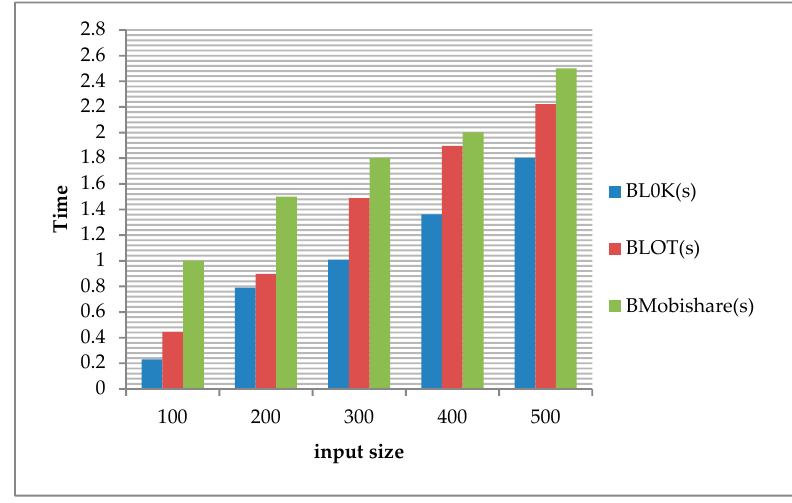
Figure 11. Computation performance comparisons.